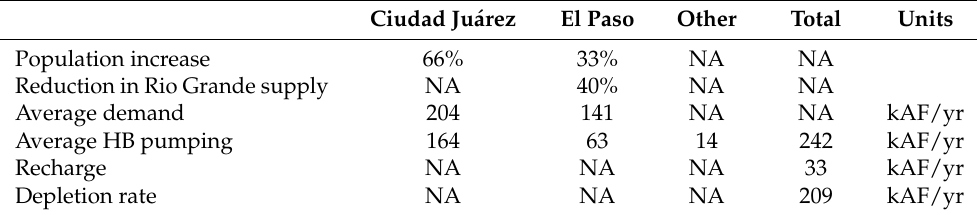
Table 3. Summary of business-as-usual scenario.